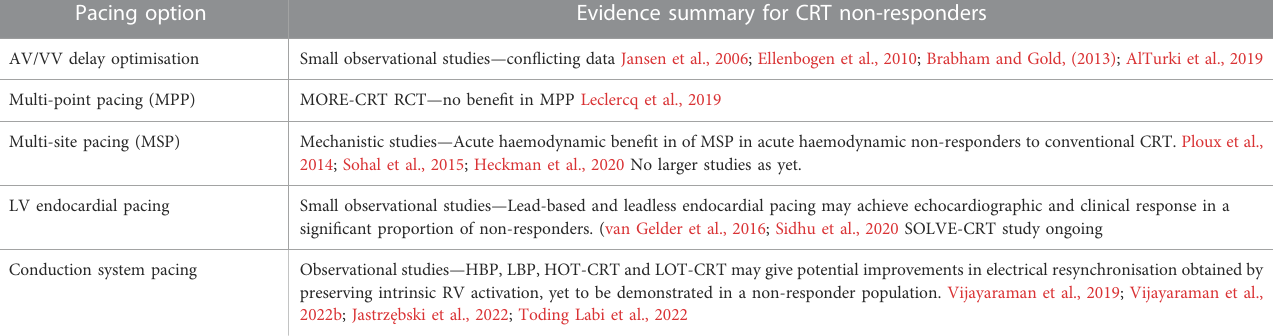
TABLE 1 Summary of different pacing options for CRT non-responders. Pacing